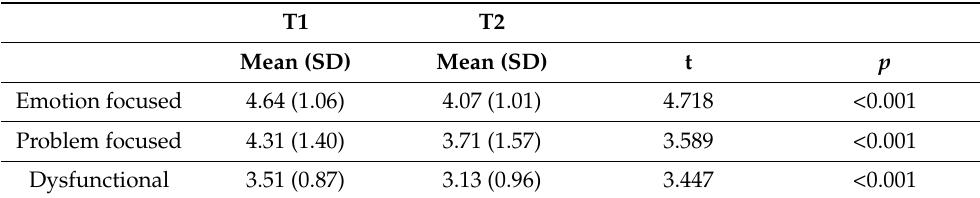
Table 3. Average scores for alternative grouping of the coping strategies on two measurements during the COVID-19 pandemic. T1